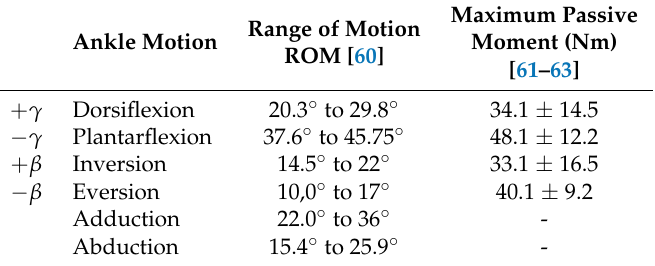
Figure 4. Basic ankle movements. Figure 2: Dynamic Forces which are involved while Crocking Figure 1. Ankle joint movements in three orthogonal planes [59]. Table 1. ROM and moment requirement for the human